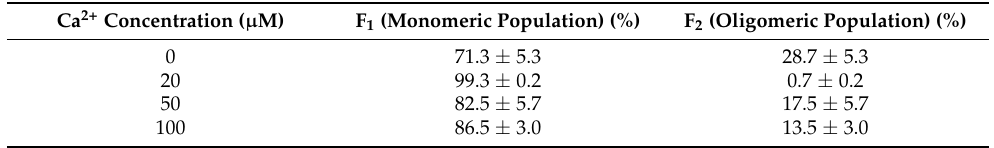
Table 1. Fraction weighed by brightness values recovered with PCH analysis for PH-YFP